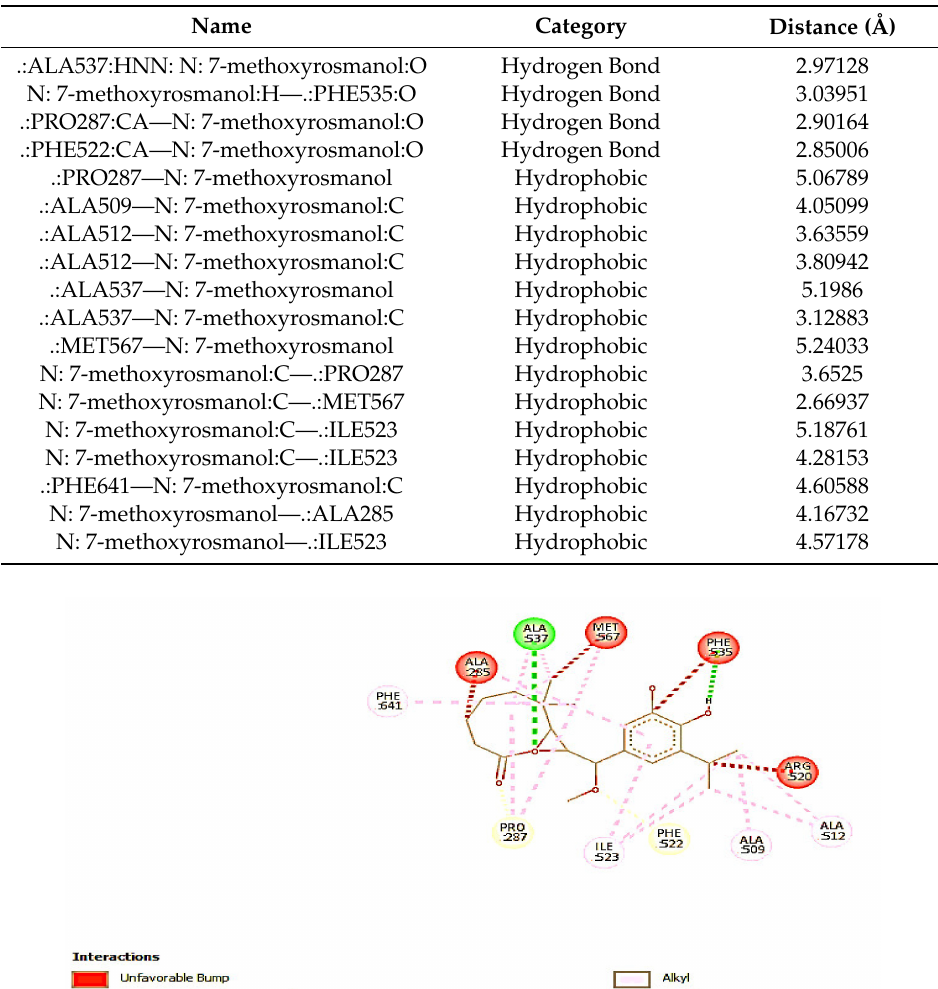
Table 3. Hydrogen and hydrophobic interactions of 7-methoxyrosmanol and alpha-glucosidase. Name